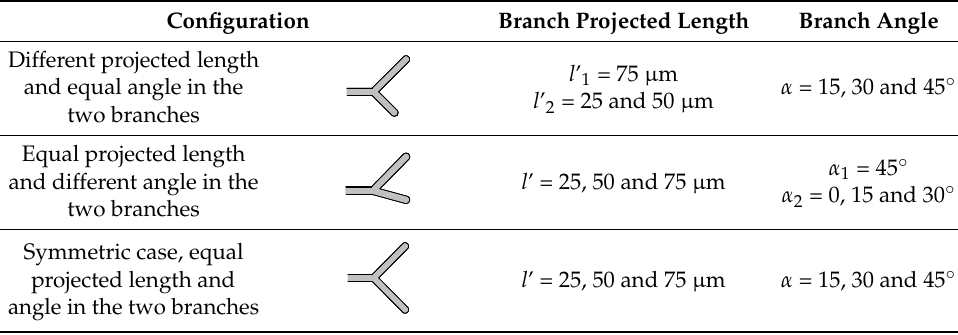
Table 1. Initial dimensions of the bifurcated crack tip.